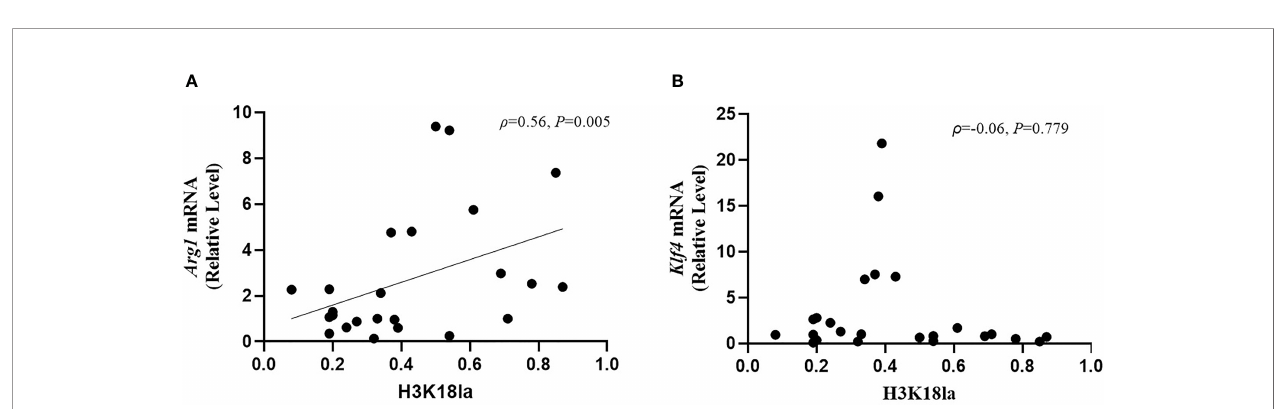
FIGURE 7 | H3K18 lactylation correlation with markers of macrophages function. The protein level of H3K18la had a positive correlation with Arg1 mRNA expression (Spearman correlation coef fi cient=0.56, P =0.005) but no correlation with Klf4 mRNA expression (Spearman correlation coef fi cient=-0.06, P =0.779). H3K18la, relative density of H3K18 lactylation in western blotting. qRT-PCR was used to detect Arg1 (A) and Klf4 (B) mRNA expression. GAPDH was used as an internal